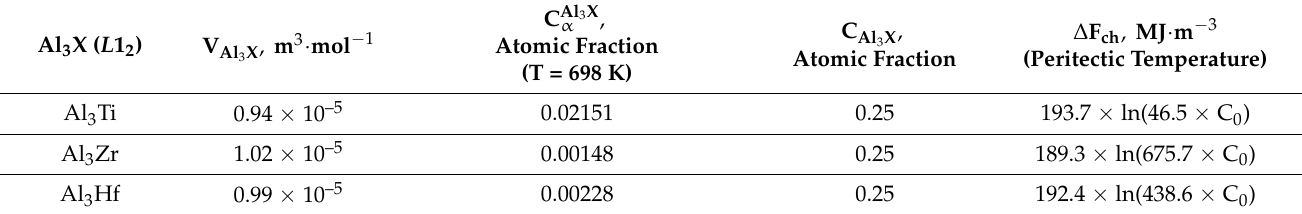
Table 4. Calculation of the chemical driving force ∆ F ch , which determines the precipitation of the Al 3 X